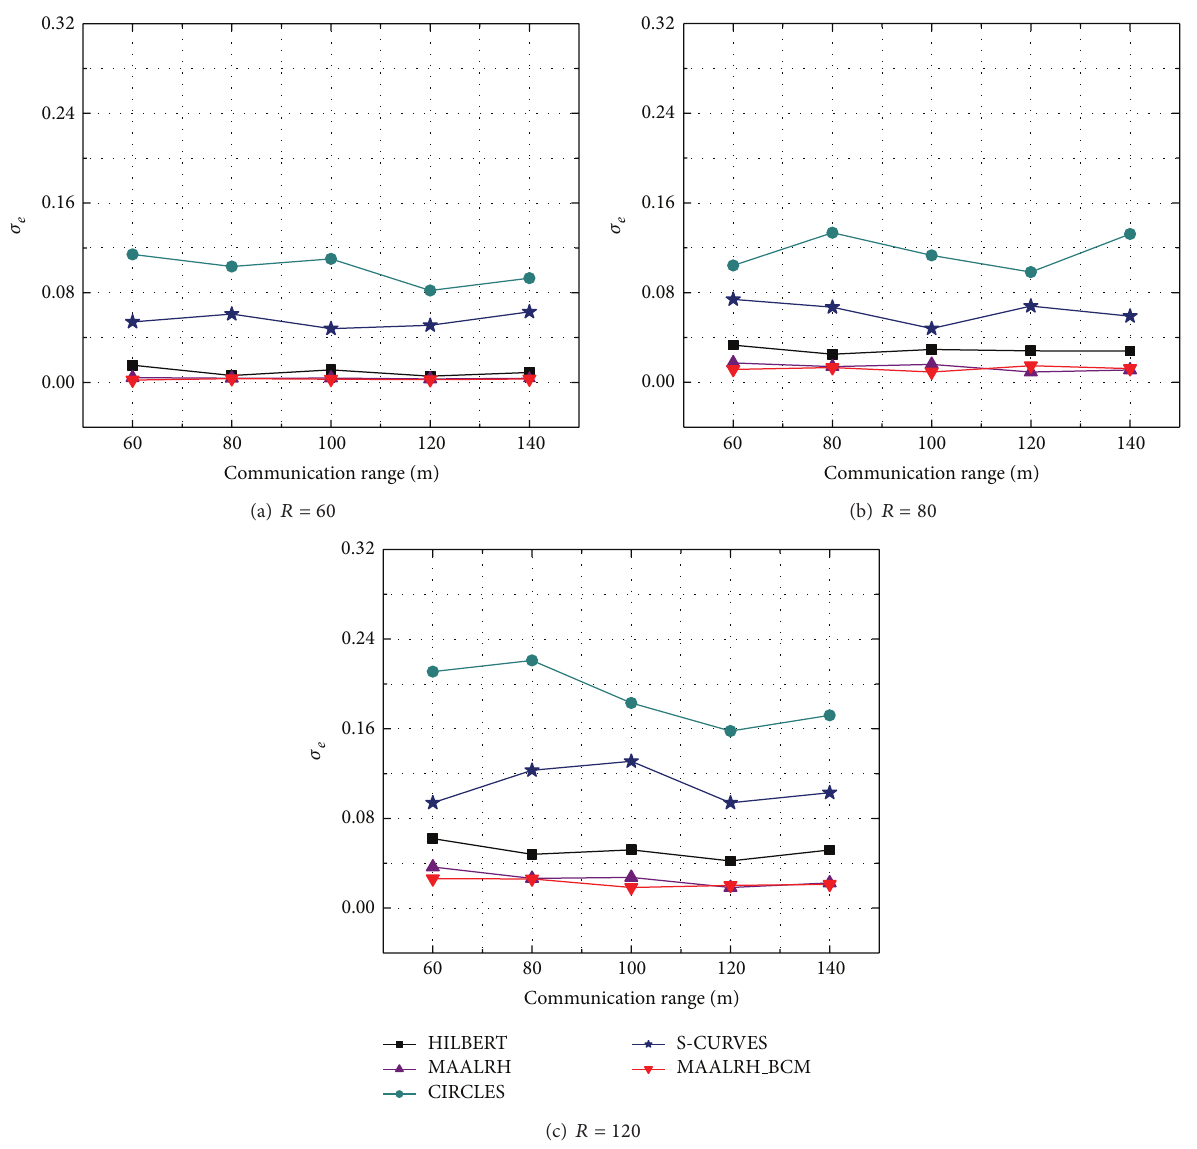
Figure 11: Standard deviation with different